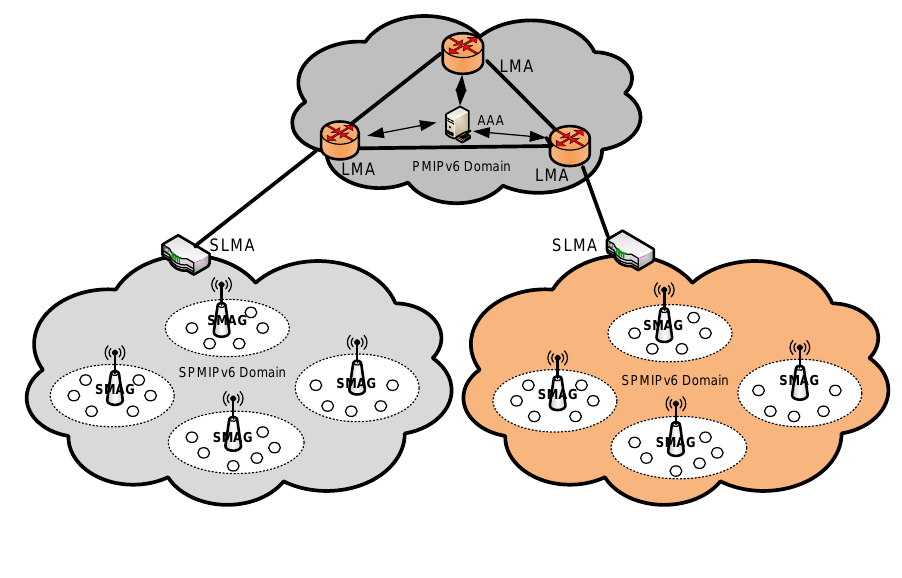
Figure 1. Sensor Proxy Mobile IPv6